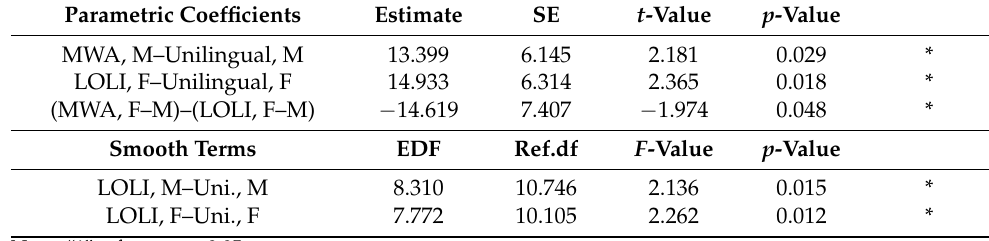
Table 4. Summary of significant effects.